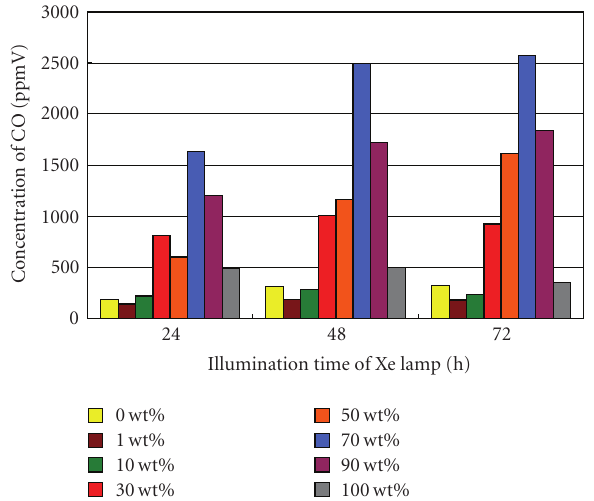
Figure 5: Comparison of produced concentration of CO among di ff erent R under the illumination condition with UV light.